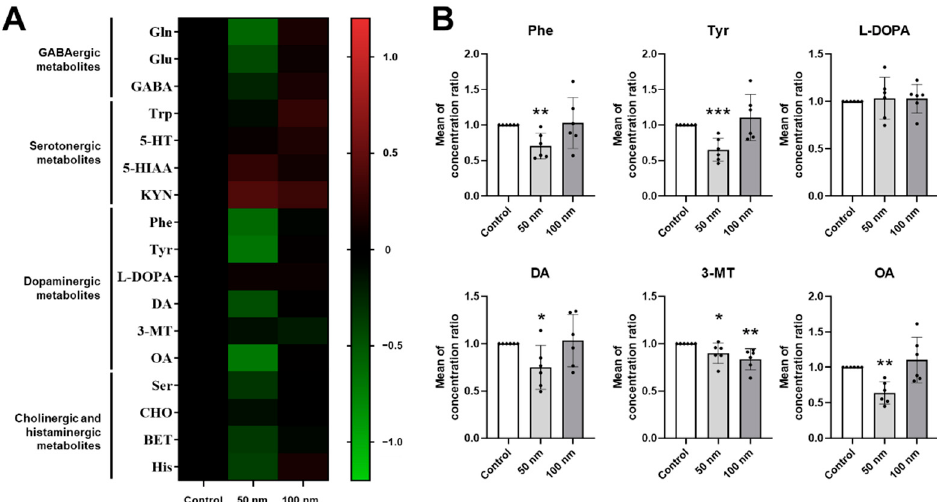
Figure 3. Quantitative analysis of endogenous neurochemicals in polystyrene nanoparticles (PS- NPs)-exposed zebrafish larvae. ( A ) Heatmap of endogenous neurochemicals relative to the control. The normalized Z-scores were calculated by the mean of the concentration ratio and standard deviation in each experimental group. Experimental concentration of both PS-NPs was 1000 ppm. ( B ) The changes of dopaminergic metabolites in PS-NPs-exposed zebrafish larvae. Each metabolite was calculated as the mean of concentration ratio that was expressed as the ratio of the neurotransmitter compared to the control in each experimental groups. Data sets were expressed as the means ± standard error of the mean and statistical significance was set at 0.05, 0.01, and 0.001 (* p ≤ 0.05, ** p